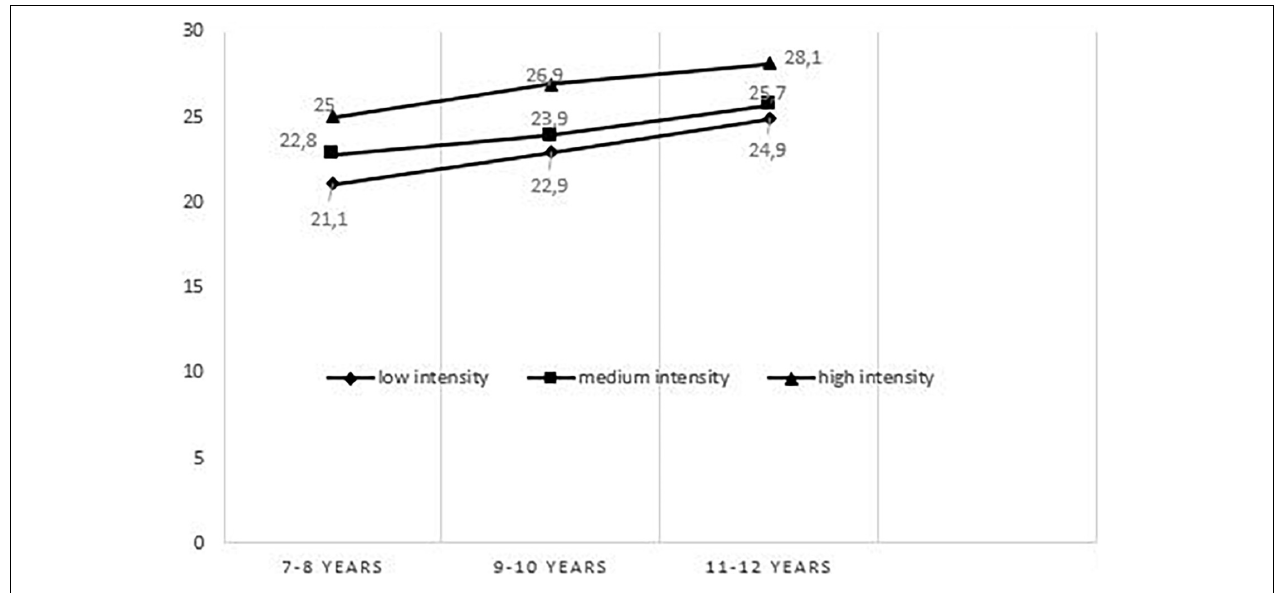
FIGURE 5 | Mean of the static subtest score as a function of intensity and age group. TABLE 6 | Comparison between the properties of the tests for the evaluation of facial emotion recognition and our test. REF: TTC Ekman POFA test DANVA 2